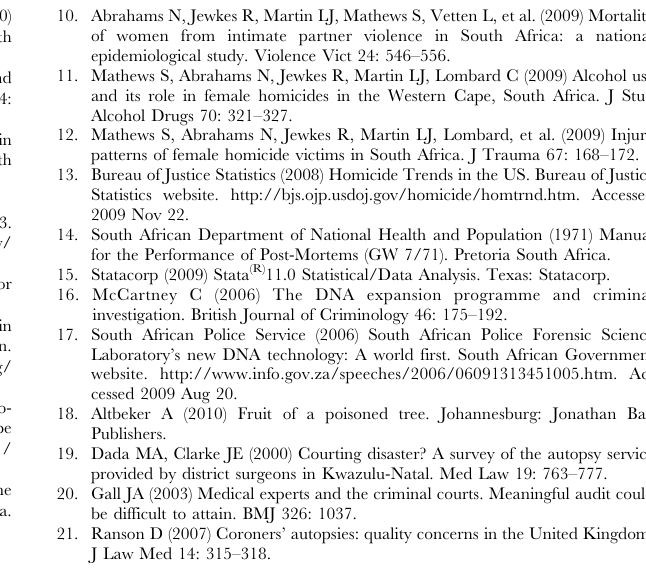
Table S1 Characteristics of the victim, suspect/perpetrator and case investigation by whether or not the suspect/perpetrator was charged and whether there was a conviction among those charged (weighted data/unadjusted odds ratios). Table S2 The distribution of indicators off forensic pathology variables and forensic management of female homicide cases by suspect/perpetrator charged and suspect/perpetrator convicted (weighted data/unadjusted odds